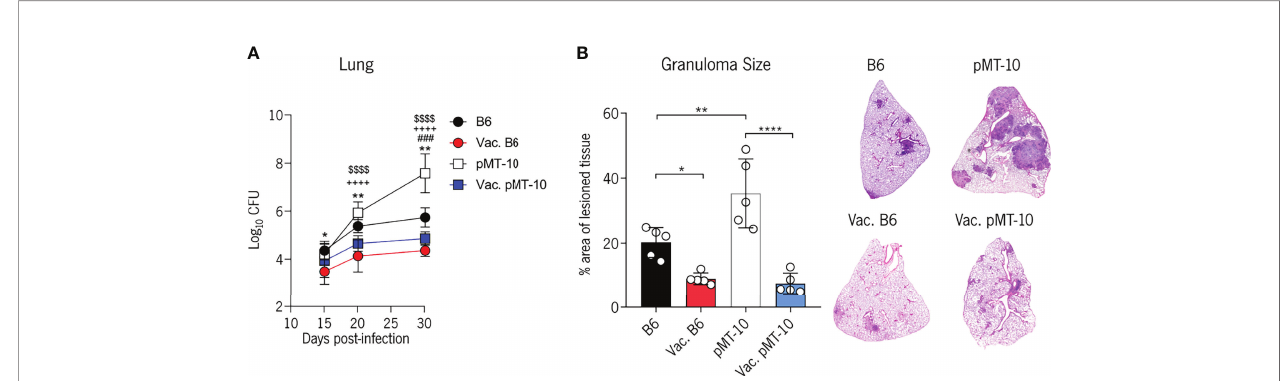
FIGURE 1 | BCG vaccination prevents the extensive Mtb proliferation and lung pathology induced by IL-10 overexpression. B6 and pMT-10 mice were subcutaneously vaccinated with 1 × 10 6 BCG. Unvaccinated mice were used as controls. Two months after vaccination, mice were infected with Mtb H37Rv via the aerosol route and IL-10 overexpression was initiated. (A) Lung Mtb burdens at days 15, 20, and 30 postinfection. Data represent one experiment out of three independent experiments performed, each with four to fi ve mice per group. *p < 0.05, **p < 0.01, ,### p < 0.001, **** ,++++,$$$$ p < 0.0001 by one-way ANOVA followed by Tukey ’ s test. *, represents statistical differences between unvaccinated and BCG-vaccinated B6 mice; #, represents statistical differences between unvaccinated B6 and pMT-10 mice; +, represents statistical differences between unvaccinated pMT-10 and BCG-vaccinated B6 mice; $, represents statistical differences between unvaccinated pMT-10 and BCG-vaccinated pMT-10 mice. (B) Percentage of in fi ltrated lung area at day 30 postinfection with Mtb and representative H&E lung sections. Data are represent one experiment out of two independent experiments performed, each with four to fi ve mice per group. *p < 0.05, **p < 0.01, ****p < 0.0001 by one-way ANOVA followed by Tukey ’ s